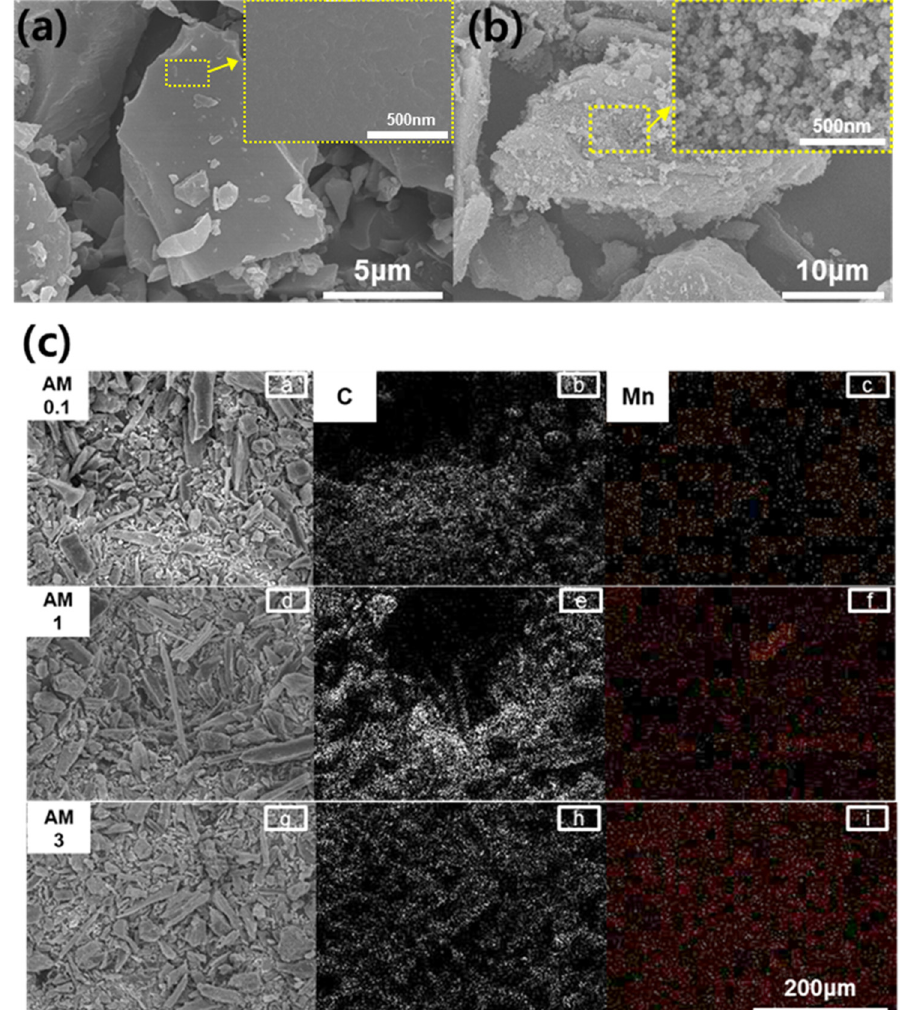
Figure 2. Scanning electron microscopy (SEM) images for ( a ) AC; ( b ) AM1 composites; and ( c ) Scanning electron microscopy with energy dispersive X-ray spectroscopy (SEM-EDS) mapping of AM0.1, AM1, and AM3 composites: (c-a, c-d and c-g) SEM images, (c-b, c-e and c-h) C distribution and (c-e, c-f